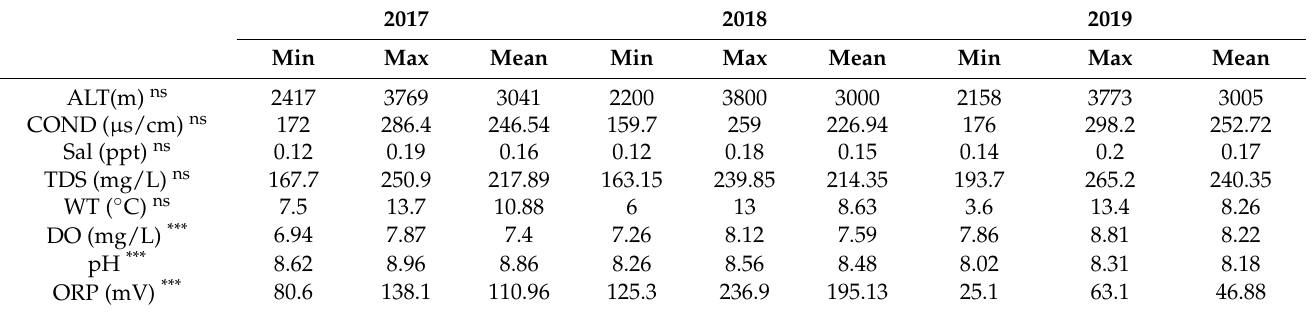
Table 1. General statistics of local environmental variables and results of the Kruskal-Wallis test for three periods. “***” denote significant differences at p < 0.05 and p < 0.001, respectively, whereas “ns” denotes non-significant